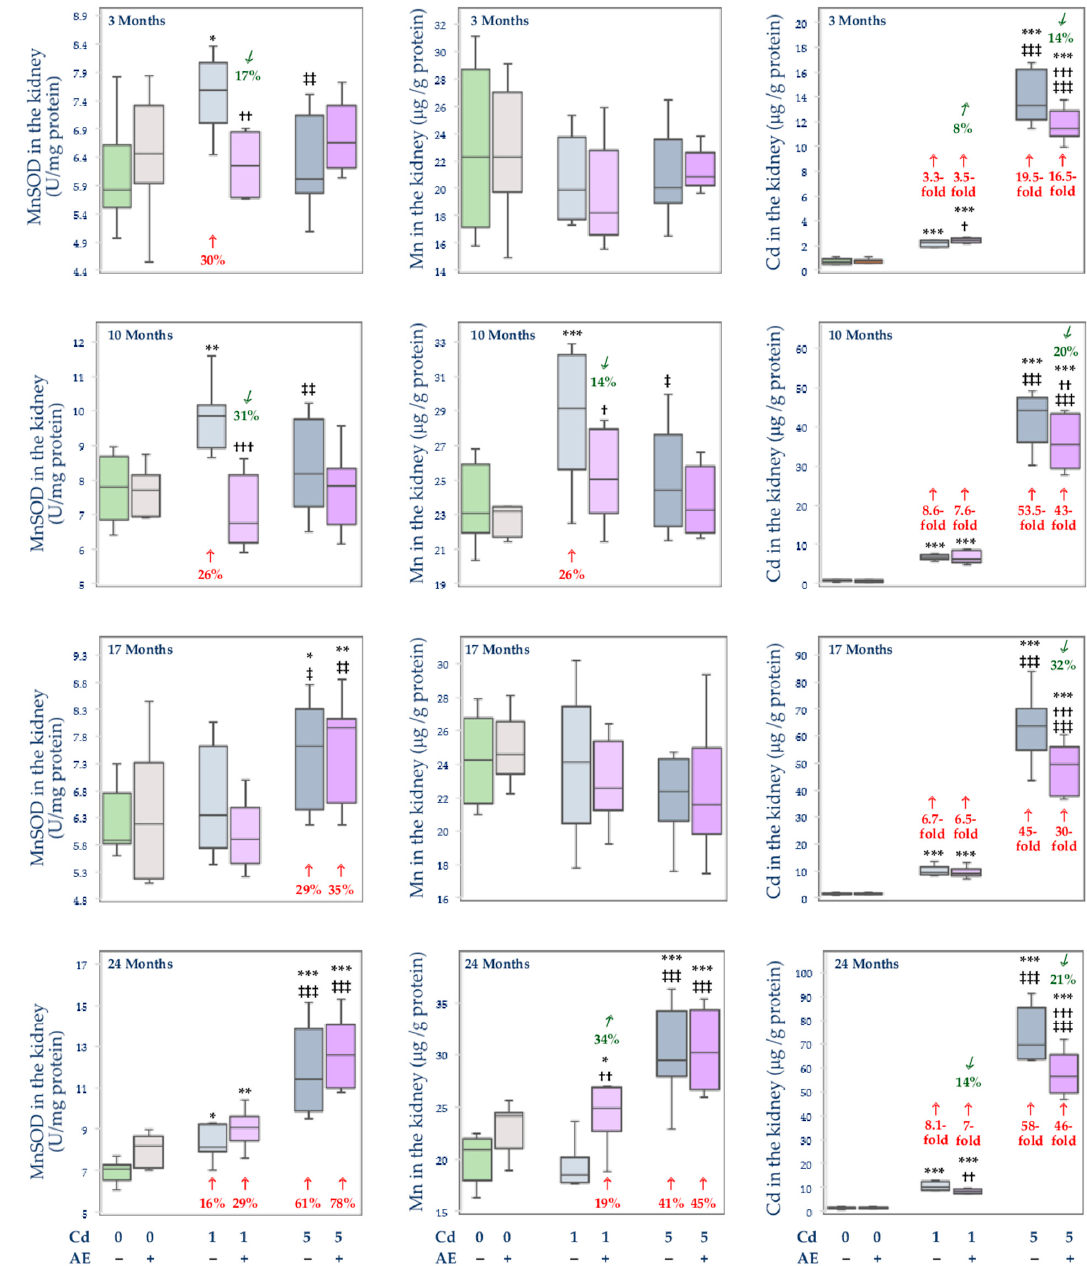
Figure 9. The activity of MnSOD and the concentrations of Mn and Cd in the mitochondrial fraction of the kidney in particular experimental groups. The rats received Cd in the diet at the concentration of 0, 1, and 5 mg/kg and/or 0.1% AE as the only drinking fluid (“+”, administered; “ − ”, without administration). Data represent a median and 25–75% confidence interval (the horizontal lines within the bars presenting the confidence interval represent median values), as well as the minimum and maximum values for eight rats in each experimental group (except for seven animals in the AE, Cd1, and Cd5 groups after 24 months). Statistically significant differences (Kruskal-Wallis post hoc test): * p < 0.05, ** p < 0.01, *** p < 0.001 vs. control group; † p < 0.05, †† p < 0.01, ††† p < 0.001 vs. respective group receiving Cd alone (Cd1 or Cd5 group); ‡ p < 0.05, ‡‡ p < 0.01, ‡‡‡ p < 0.001 vs. respective group receiving the 1 mg Cd/kg diet alone (Cd1 group) or with the AE (Cd1 + AE group) are marked. The values below and above the bars (or above the bars) indicate percentage changes or folds of changes compared to the control group ( ↑ , increase) or the respective group receiving Cd alone